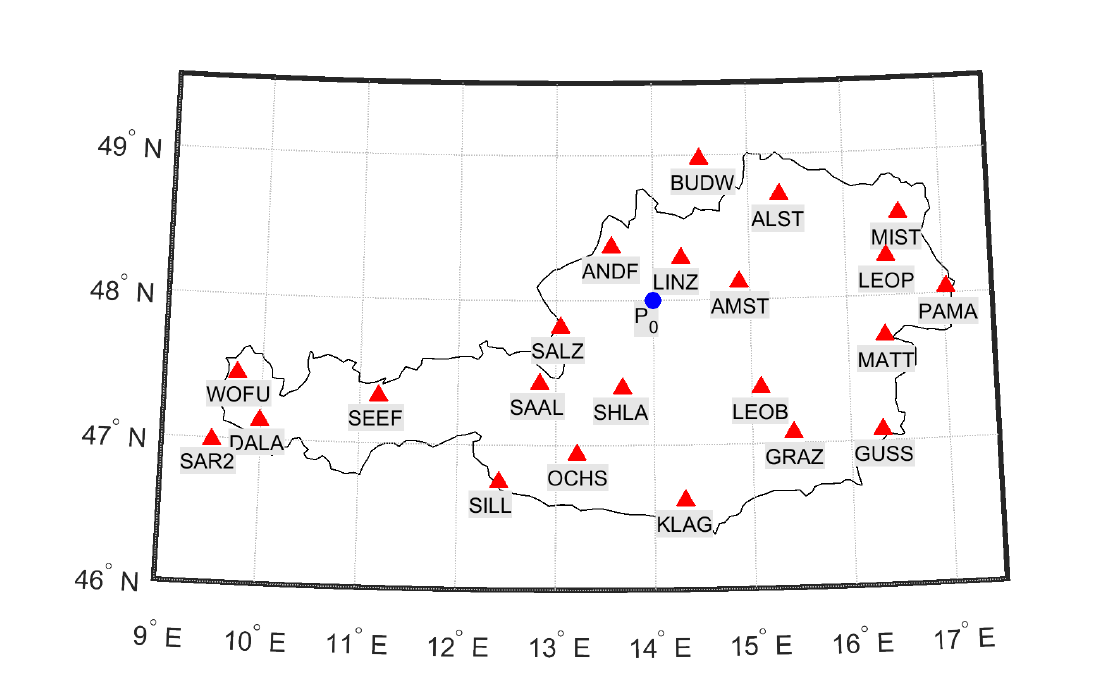
Figure 1. GNSS station network used for processing the Regiomontan model. Red triangles depict the permanent reference stations selected for this purpose. The blue dot indicates the center of the Taylor expansion P 0